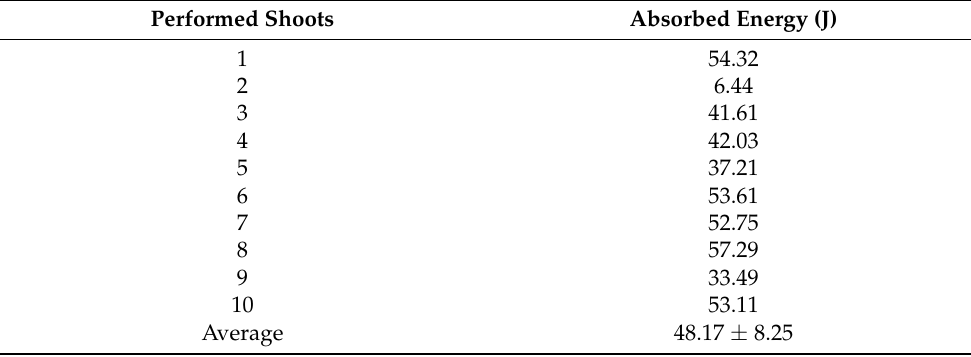
Table 4. Absorption energy in ballistic testing of a 30 vol% fiber composite